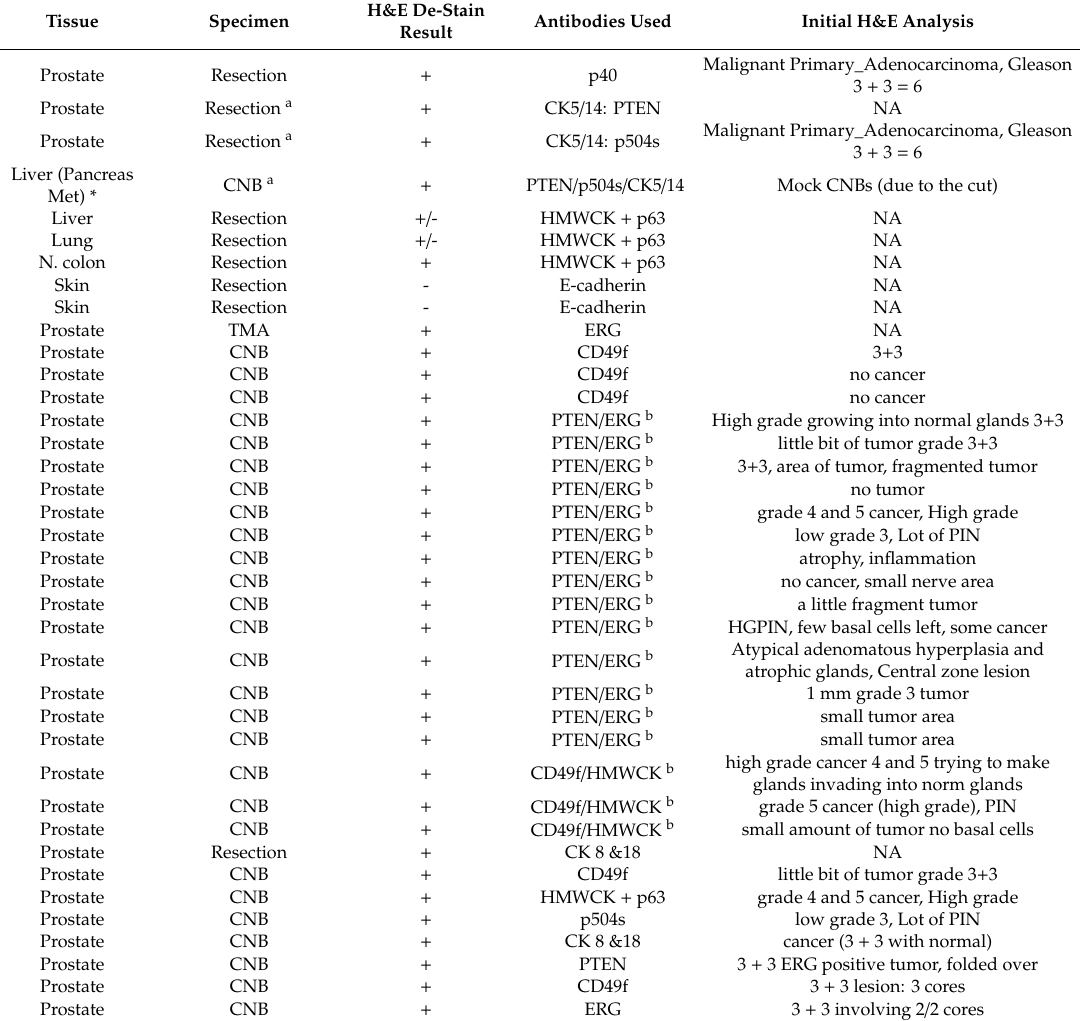
Table 1. List of initially assess sample H&E stained slides with specimen parameters, de-stain results and antibodies